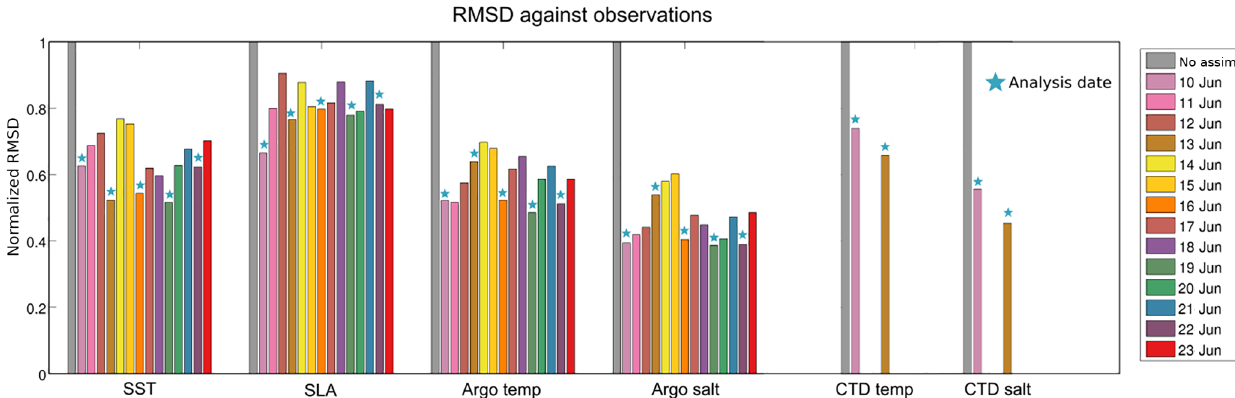
Figure 9. Evolution of the normalized RMSD against observations for the GNR_CTD